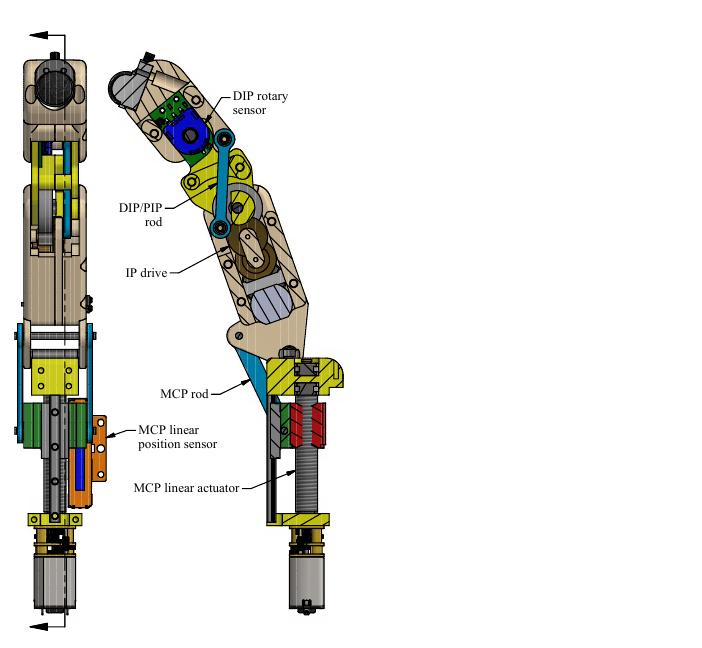
Figure 4. Mechanical design and drives of a fully actuated finger; design intended for index and middle